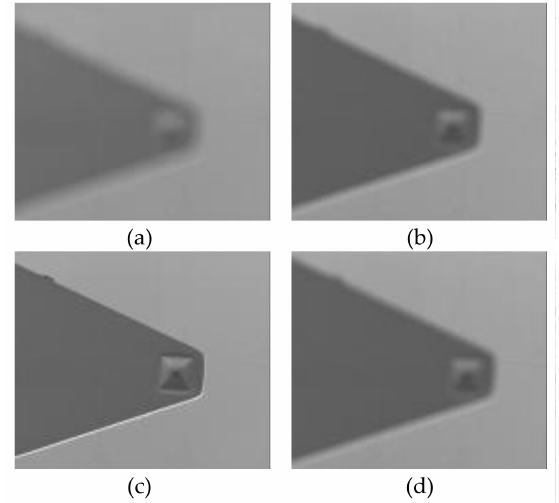
Figure 6. The sharpness variation during the continuous movement of the AFM cantilever in the Z-direction ( a , b ) The AFM cantilever located below the focus plane; ( c ) The AFM cantilever reached the focal plane; ( d ) The AFM cantilever located above the focus